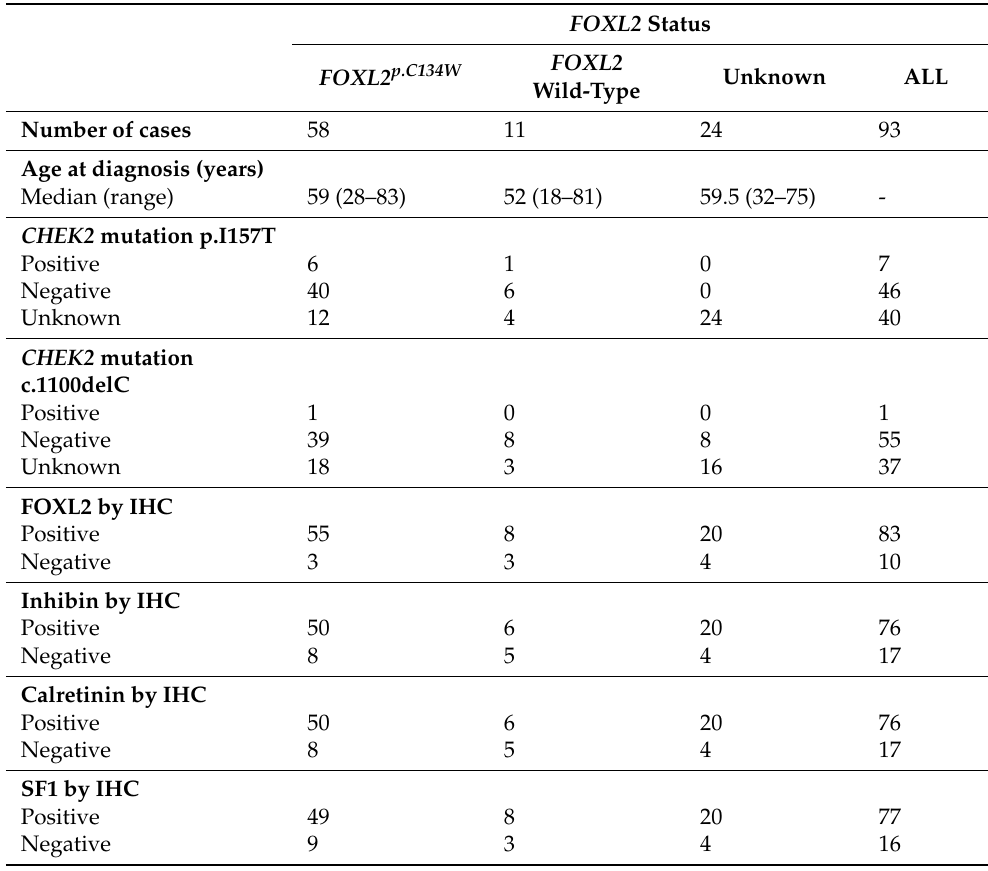
Table 1. Characteristics of cases diagnosed with ovarian granulosa cell tumors classified per status of the FOXL2 p.C134W